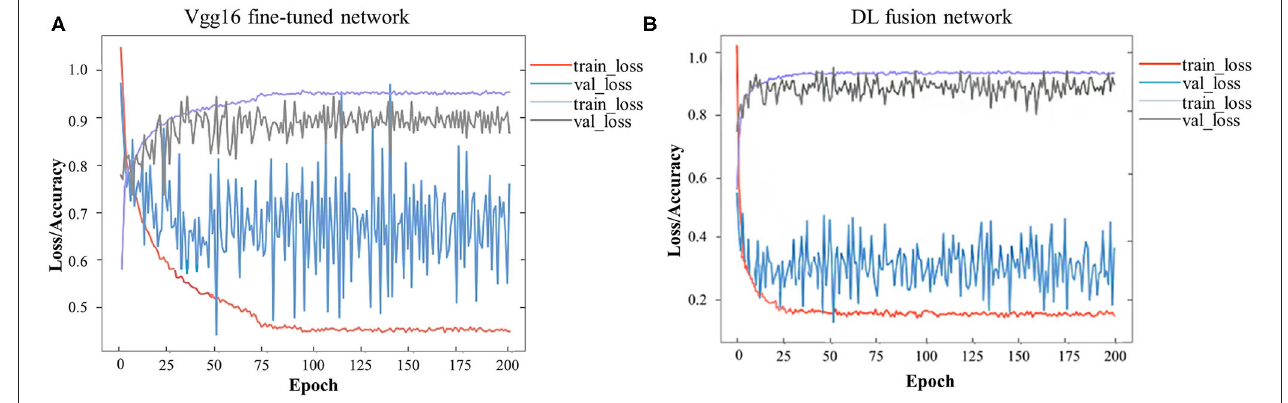
FIGURE 3 | Loss and accuracy over epochs of training/ validation process. (A) Vgg16 fine-tuned network, (B) DL fusion network.